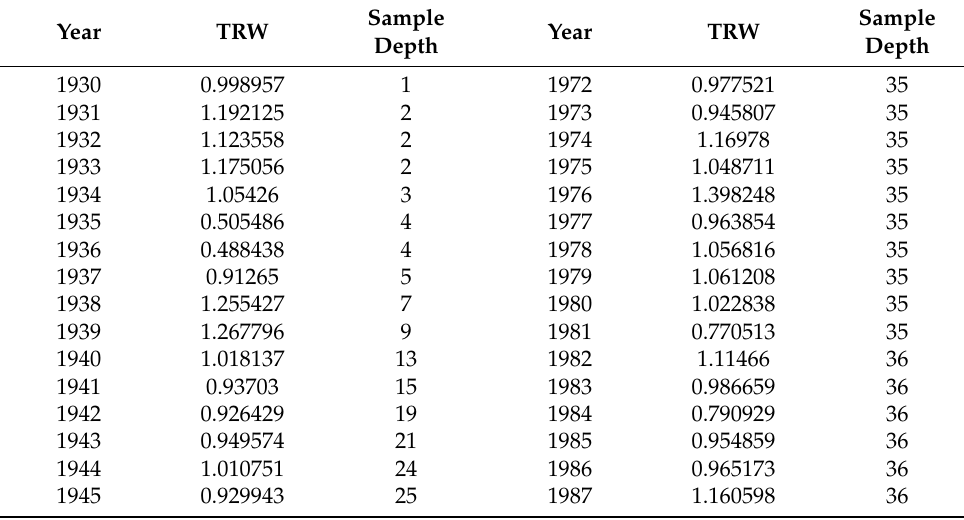
Table A1. Values of standard tree ring width